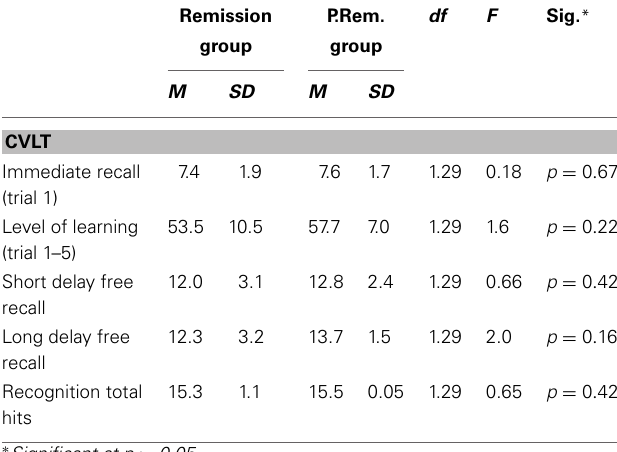
Table 3 | Test performance and descriptive data for the remission group ( N = 18) and the partial remission group (P.Rem. group) ( N =